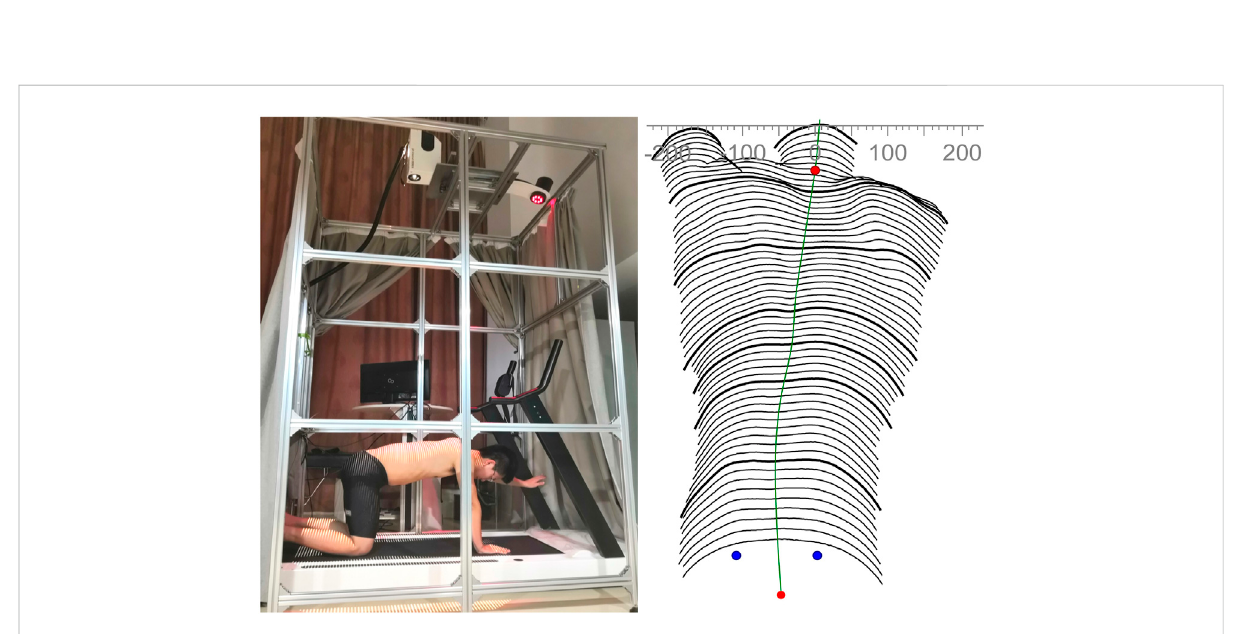
FIGURE 2 Modi fi ed Formetric 4D device (left panel) and computerized surface topography map of the participant ’ s back (right panel). The distance between the camera and the participant ’ s back is about 2